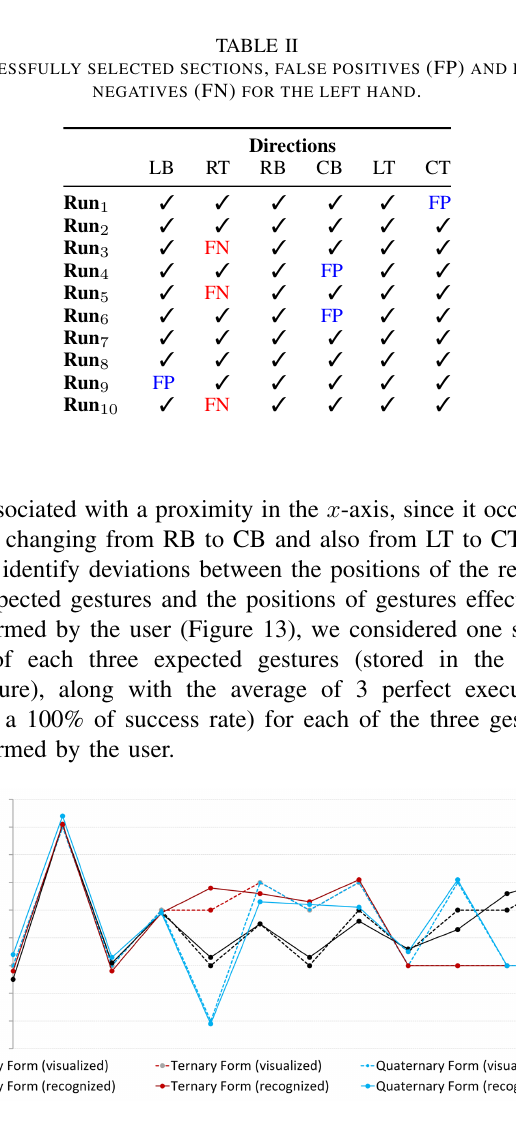
Fig. 13: Diagram of deviations between the positions of expected and recognized gestures.